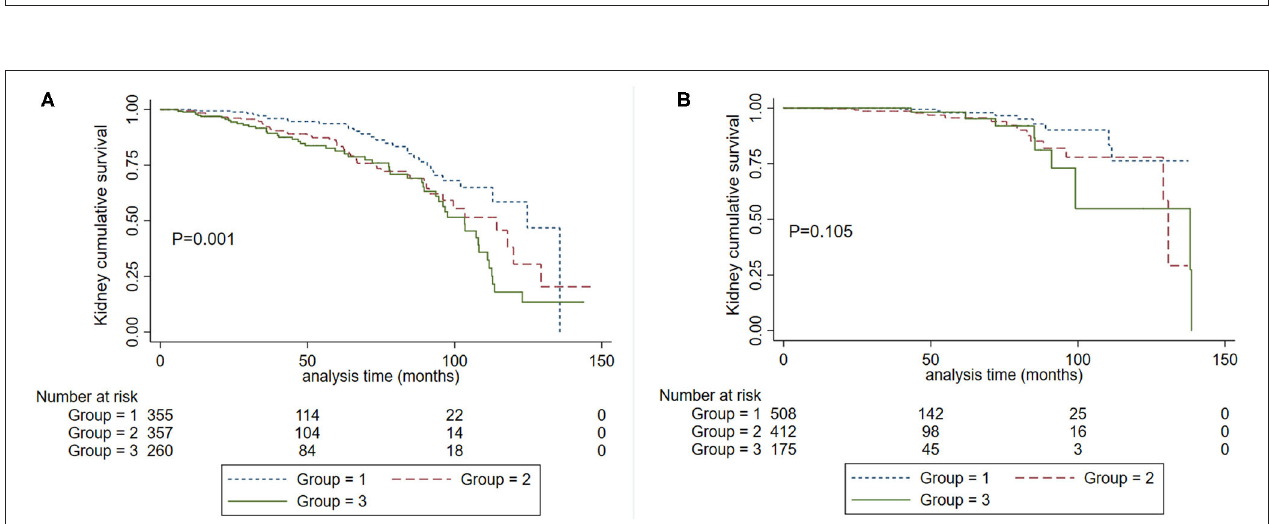
FIGURE 3 | Kaplan-Meier renal survival curves according to SBP levels in patients with baseline proteinuria > 1.0 g/d (A) and proteinuria ≤ 1.0 g/d (B) . Group 1. Systolic blood pressure < 120mm Hg. Group 2, systolic blood pressure < 140mm Hg and ≥ 120mm Hg. Group 3. Systolic blood pressure ≥ 140mm Hg.